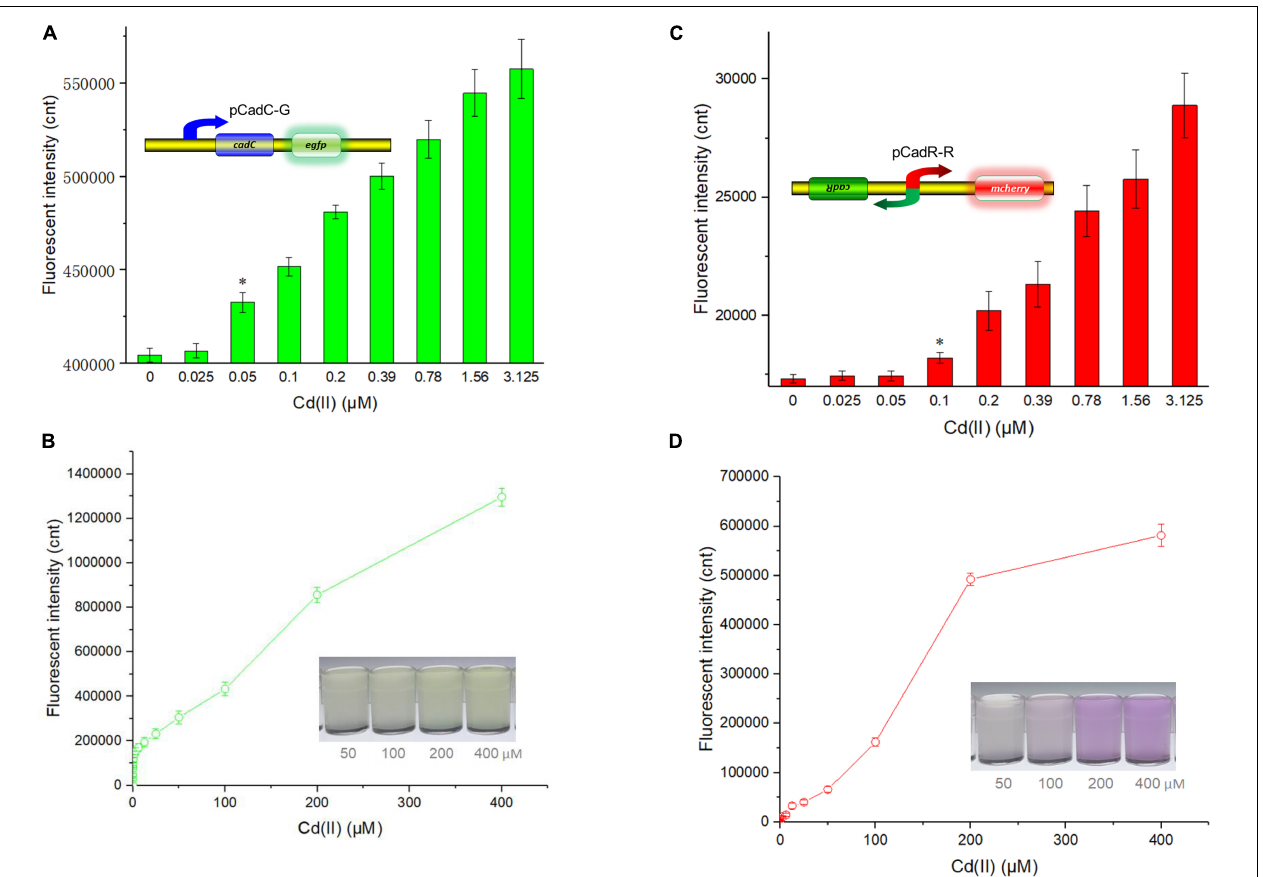
FIGURE 4 | Fluorescent signals generated by single-sensing biosensors after exposure to gradient concentrations of Cd(II). After exposure to gradient concentrations of Cd(II) generated from a double dilution method, both fluorescent signals were determined after 12 h of incubation at 37 ◦ C. Fluorescence intensity values were normalized using the absorbance at 600 nm. Results are the average of at least three independent experiments performed in triplicate. Detection limit of whole-cell biosensor TOP10/pCadC-G (A) . The asterisk indicates a significant increase (two-tailed t -test, P < 0.001) in fluorescent intensity, in comparison to the same biosensor exposed to 0 µ M Cd(II). Detection limit of whole-cell biosensor TOP10/pCadR-R (C) . The asterisk indicates a significant increase (two-tailed t -test, P < 0.01) in fluorescent intensity, in comparison to the same biosensor exposed to 0 µ M Cd(II). Response curves of whole-cell biosensor (B) TOP10/pCadC-G and (D) TOP10/pCadR-R in response to different Cd(II) concentrations. The fluorescent signal was indicated as a fluorescence count value (unit = cnt). The data values shown for each metal exposure group were obtained by subtracting the control values (with no metal exposure) from the experimental values. The typical photographs of engineered bacterial cell cultures induced by the above 50 µ M Cd(II) are